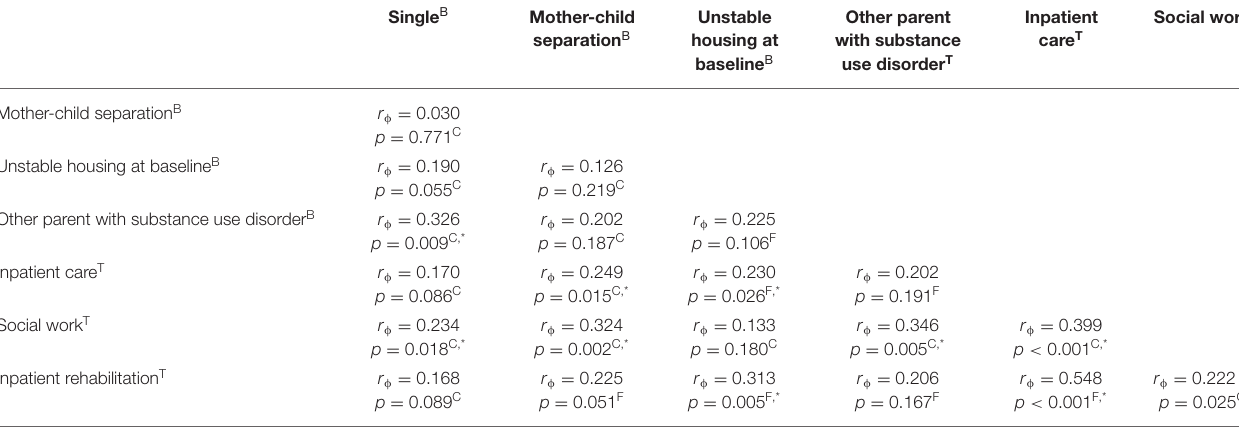
TABLE 3 | Associations between correlates of housing at discharge.